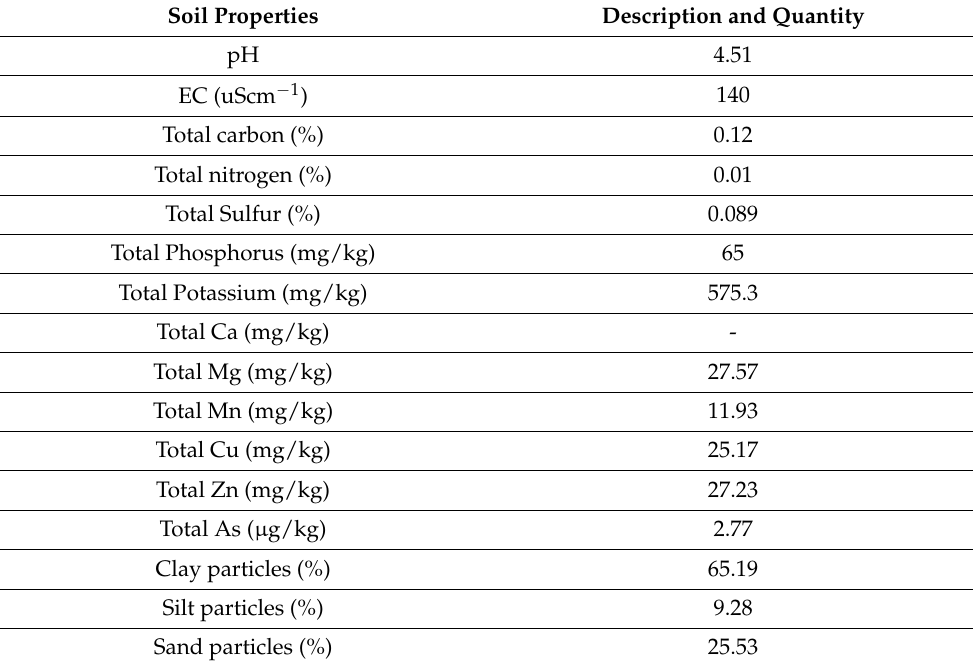
Table 2. Physicochemical properties of the soil used in the experiments.